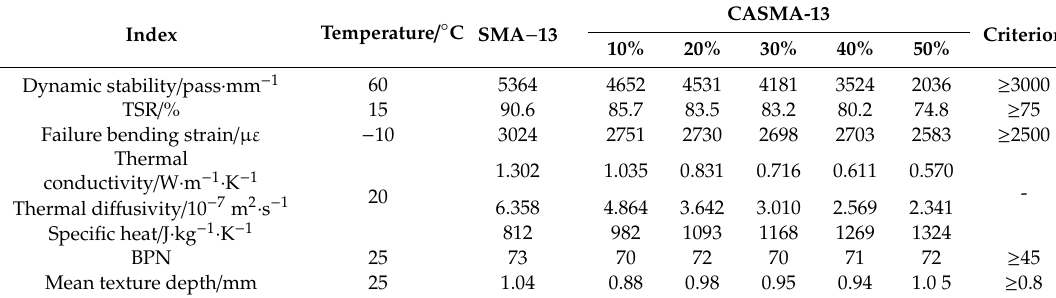
Table 7. Test results of stone mastic asphalt.